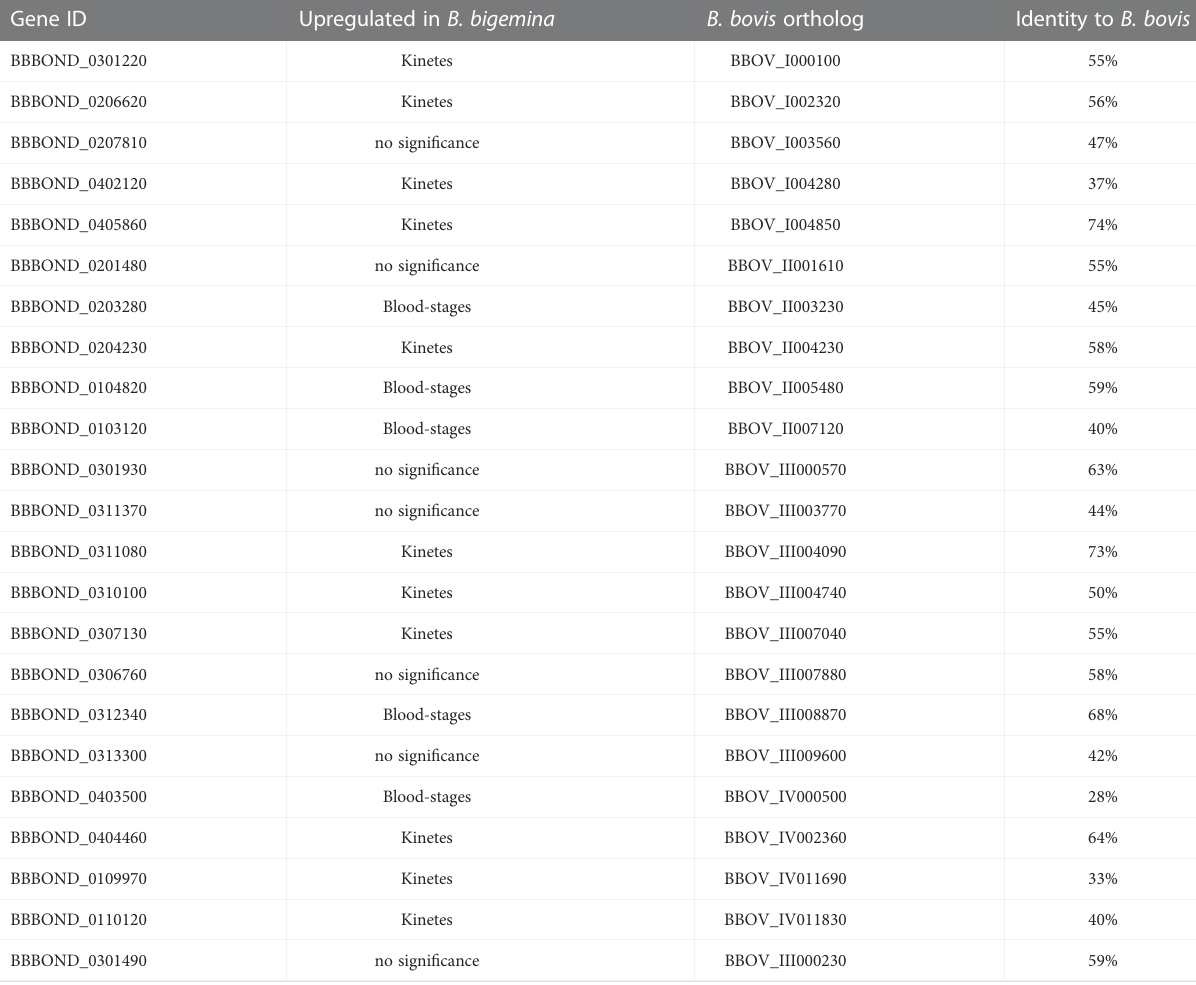
TABLE 4 AP2 gene family expressed in kinetes and blood-stages in B. bigemina and their respective orthologs in B. bovis . Gene ID Upregulated in B. bigemina B. bovis